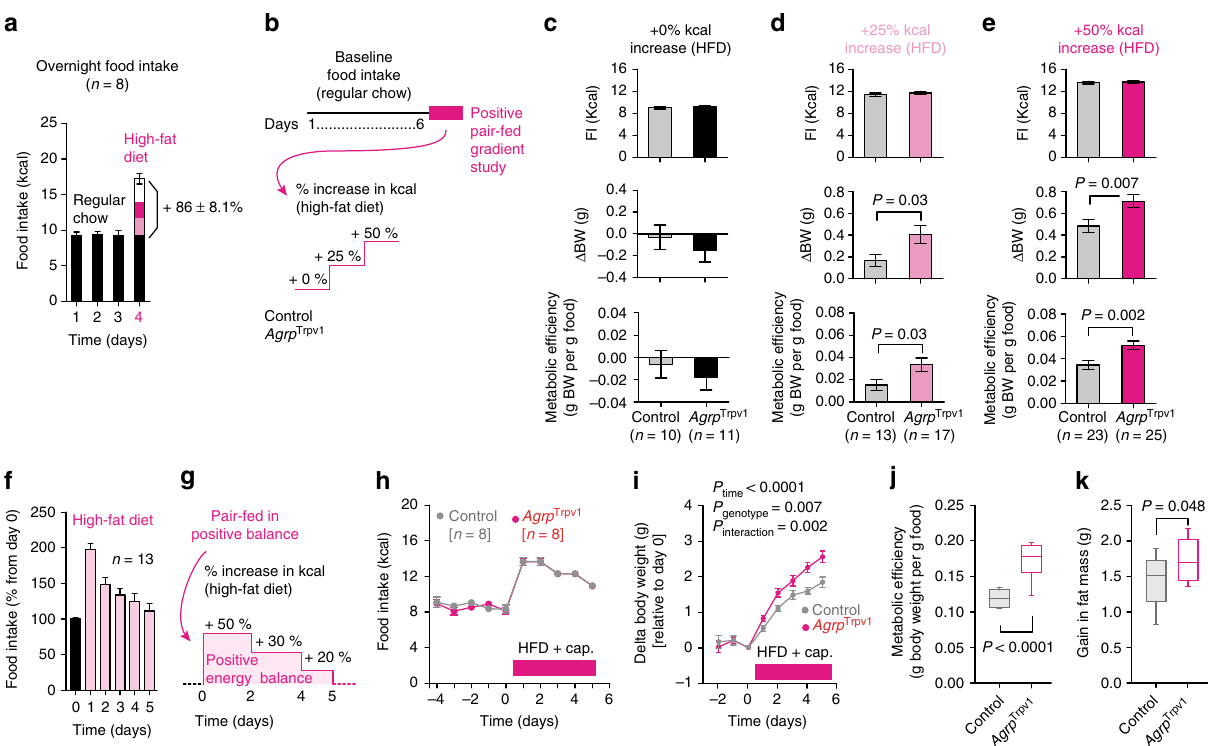
Fig. 6 Agrp neuron activity boosts fat gain in obesogenic conditions. a Physiological hyperphagia after acute switch to high-fat diet (45% kcal from fat) in mice. b Pair feeding studies: high-fat diet (0, 25 or 50% more calories compared to ad libitum normal chow food intake) was provided after injection of control and Agrp Trpv1 mice with capsaicin. c Top, Mice were fed the same number of calories as they ate during baseline food intake; Middle, delta body weight; Bottom, metabolic ef fi ciency. d Similar to c but in mice fed 25% more calories when switched to a high-fat diet. e Similar to c and d , but in mice fed 50% more calories. f Food intake measured during 5 days after switching mice to a high-fat diet (45% kcal from fat); in pink, period of dietary switch. g Control and Agrp Trpv1 mice were switched to a high-fat diet (shaded pink) after baseline food intake measurements; capsaicin was injected every day before dark cycle. h Food intake. i Delta changes in body weight relative to the day of diet switch. j Metabolic ef fi ciency and k gain in fat mass during the period in which mice were fed high-fat diet. Unpaired t -test was used in c , d , e , j and k . Two-way analysis of variance (ANOVA with time as a repeated measure was used in i . Number of mice is displayed in the fi gures. Bars and symbols indicate mean ± SEM. Boxes indicate median± 25/75 quartiles± min/ max values. Statistically signi fi cant P values are provided in the fi